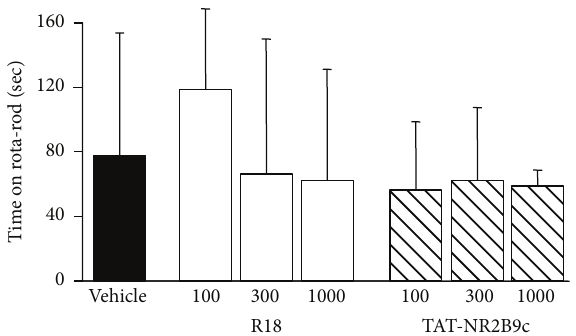
Figure 4: Rota-rod performance 24 hours after permanent MCAO for saline (vehicle) and peptide (R18 and TAT-NR2B9c at 100, 300, or 1000nmol/kg) treatment groups. Values are mean ± SD.